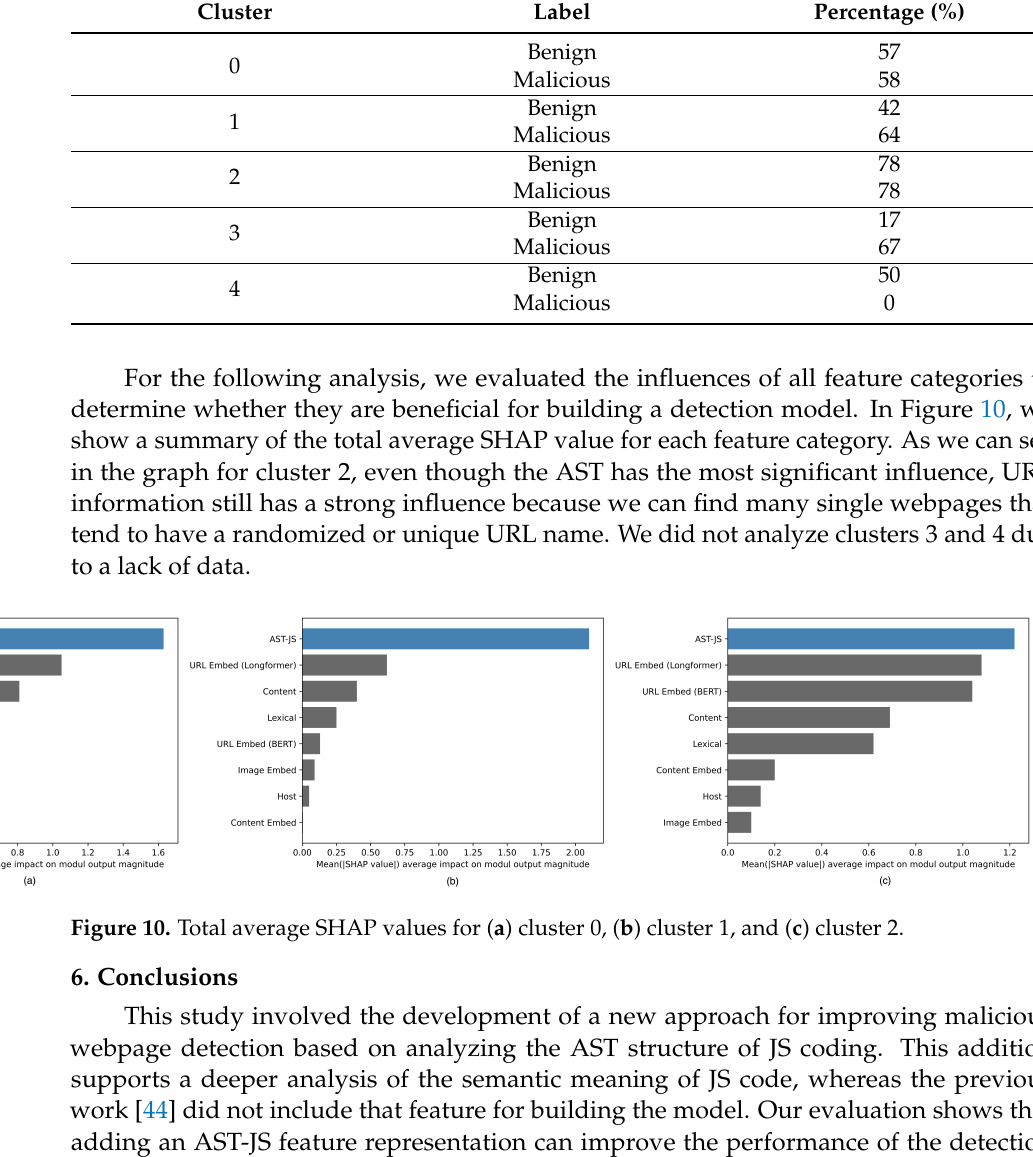
Table 8. Percentage of unique hostnames per all URLs in each cluster.